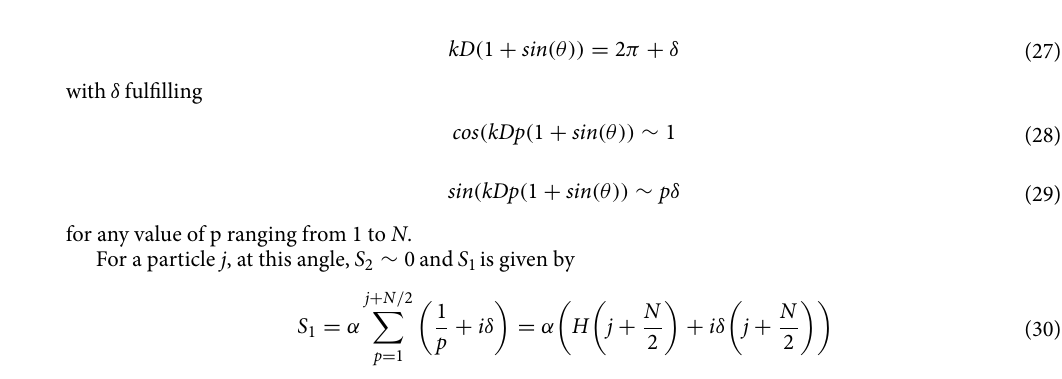
Figure 8. Color map of the torque versus wavelength and orientation angle, for a range of wavelengths between 300 and 500 nm. Yellow regions corresponds to positive torques (anti-clock wise oriented), blue regions to negative torques (clock wise oriented). In ( a ) the torque is normalized to the maximum absolute value. In ( b ) the torque is normalized to the maximum value for each wavelength. The resonant angles for different diffraction orders promoting cumulative field enhancement are marked with coloured lines (in red the first diffraction order, in black the second order and in purple the third